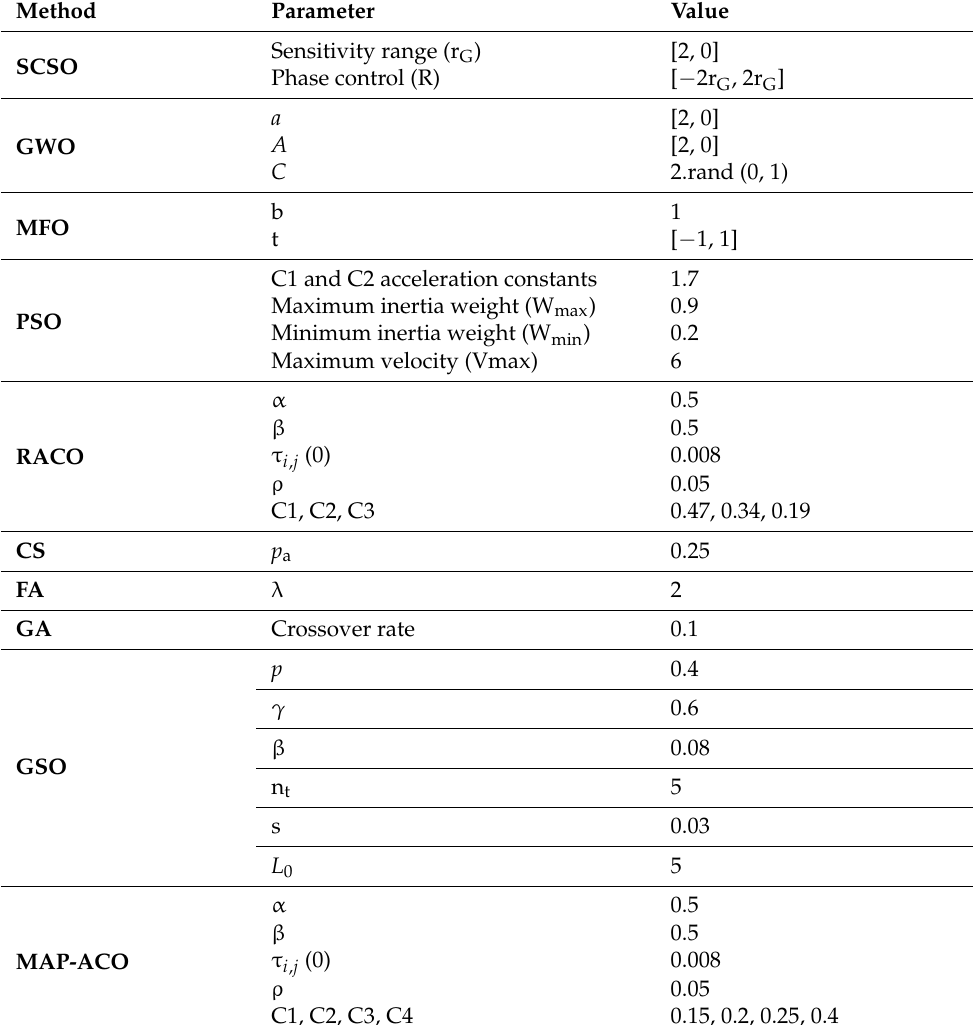
Table 2. The simulation